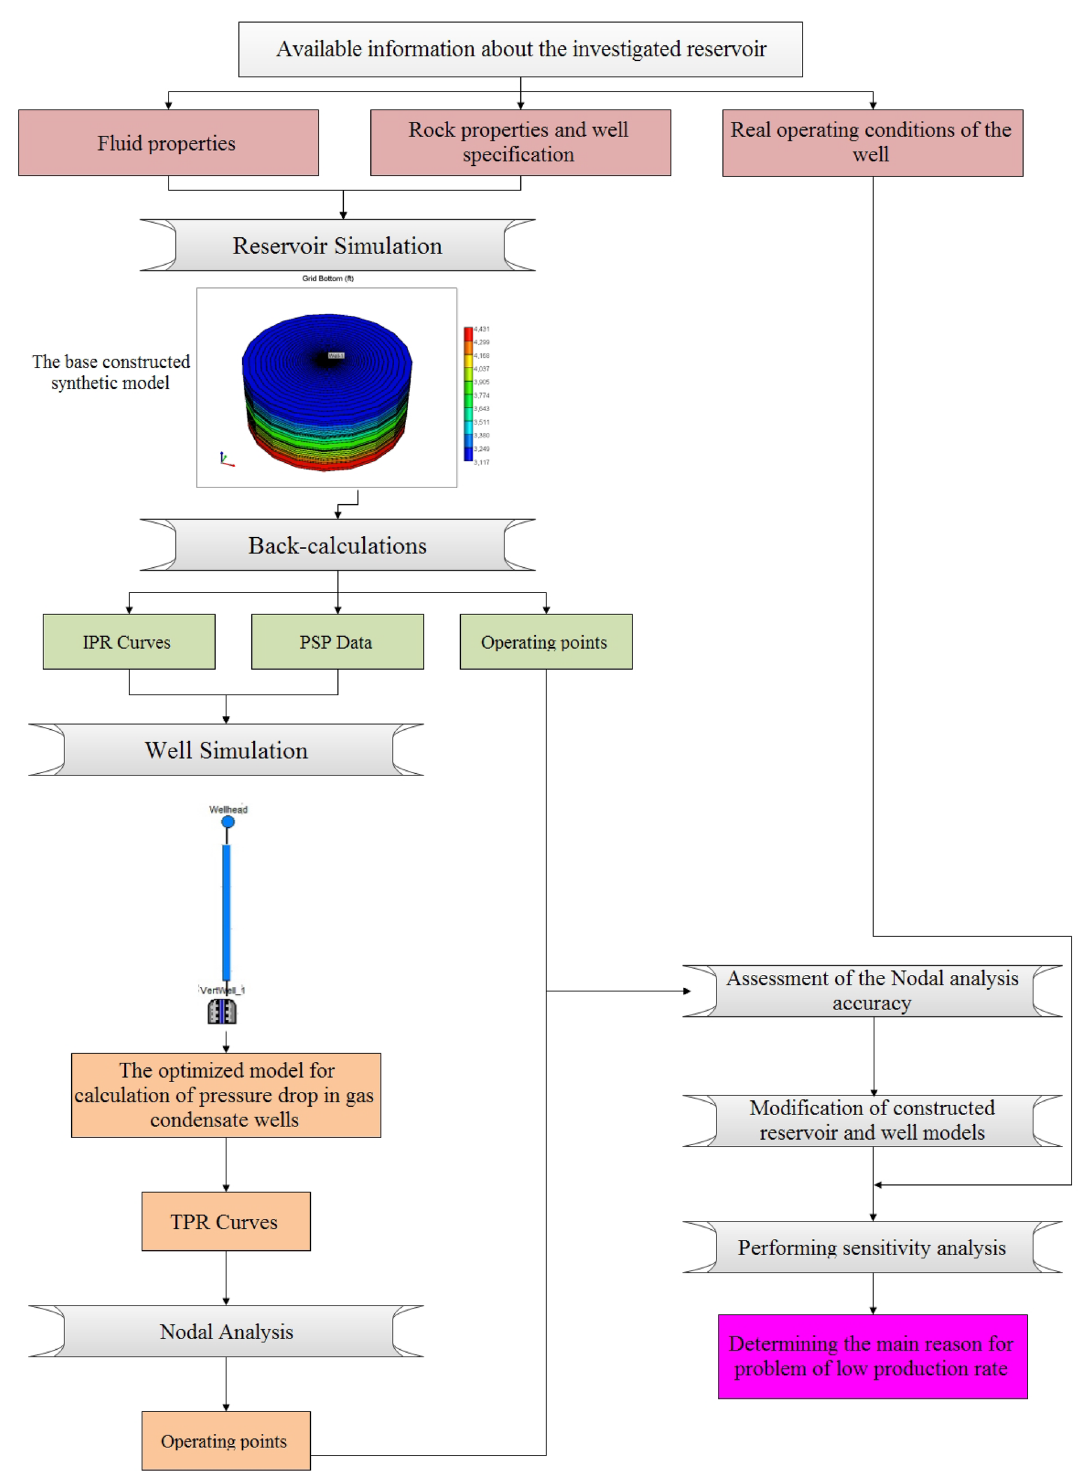
Fig. 3 Proposed strategy for integrated well performance